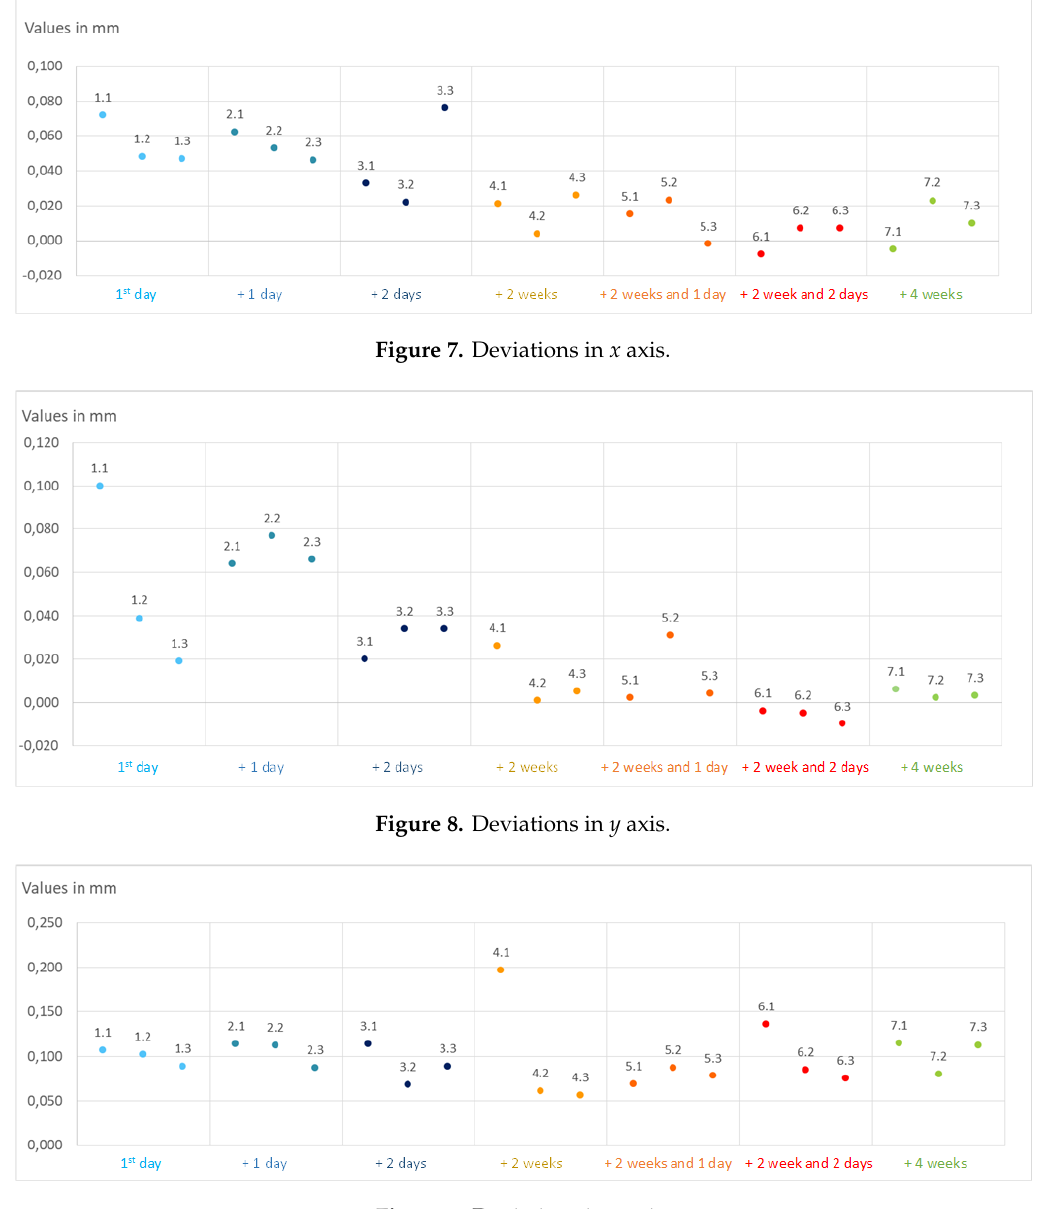
Figure 9. Deviations in z axis.